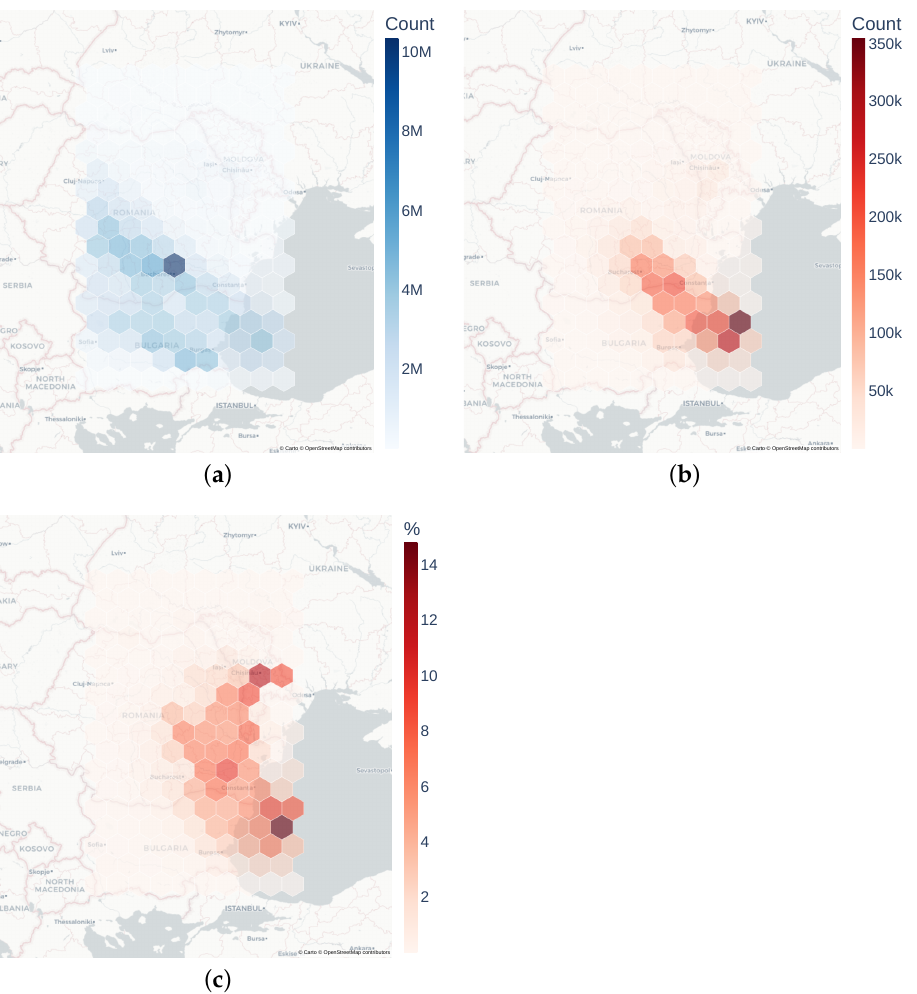
Figure 2. Aircraft densities in AoI-1 over the period between February and August 2022: ( a ) number of observed aircraft positions reported within each hexadecimal bin in AoI-1; ( b ) number of observed aircraft positions reporting a NACp of 0 within each hexadecimal bin in AoI-1; ( c ) percentage of aircraft affected by RFI per hexadecimal bin in